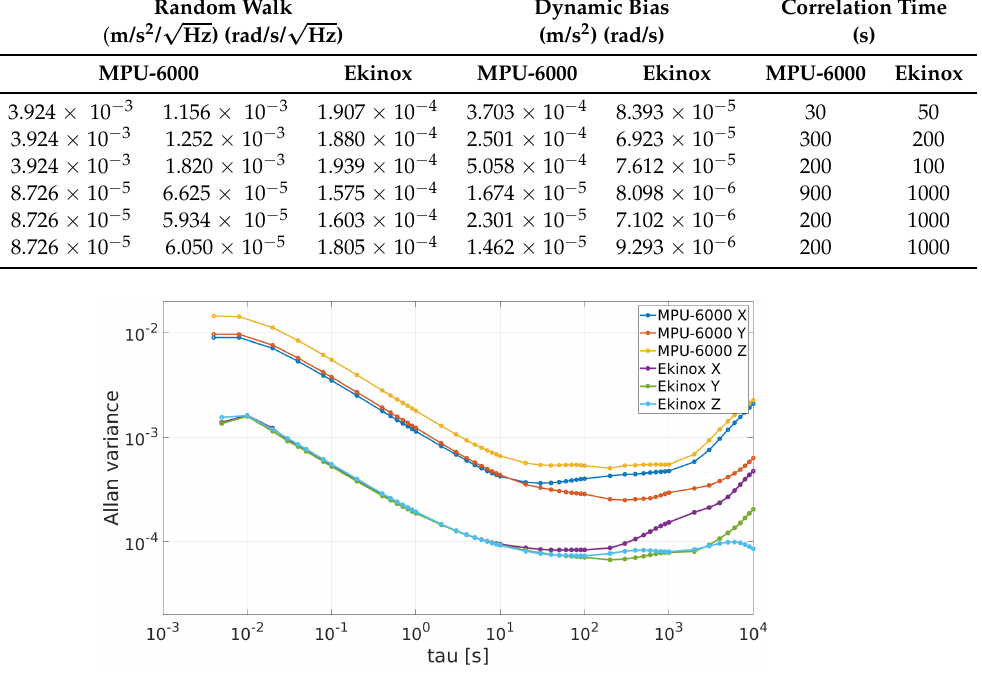
Figure 2. Allan variances plots for